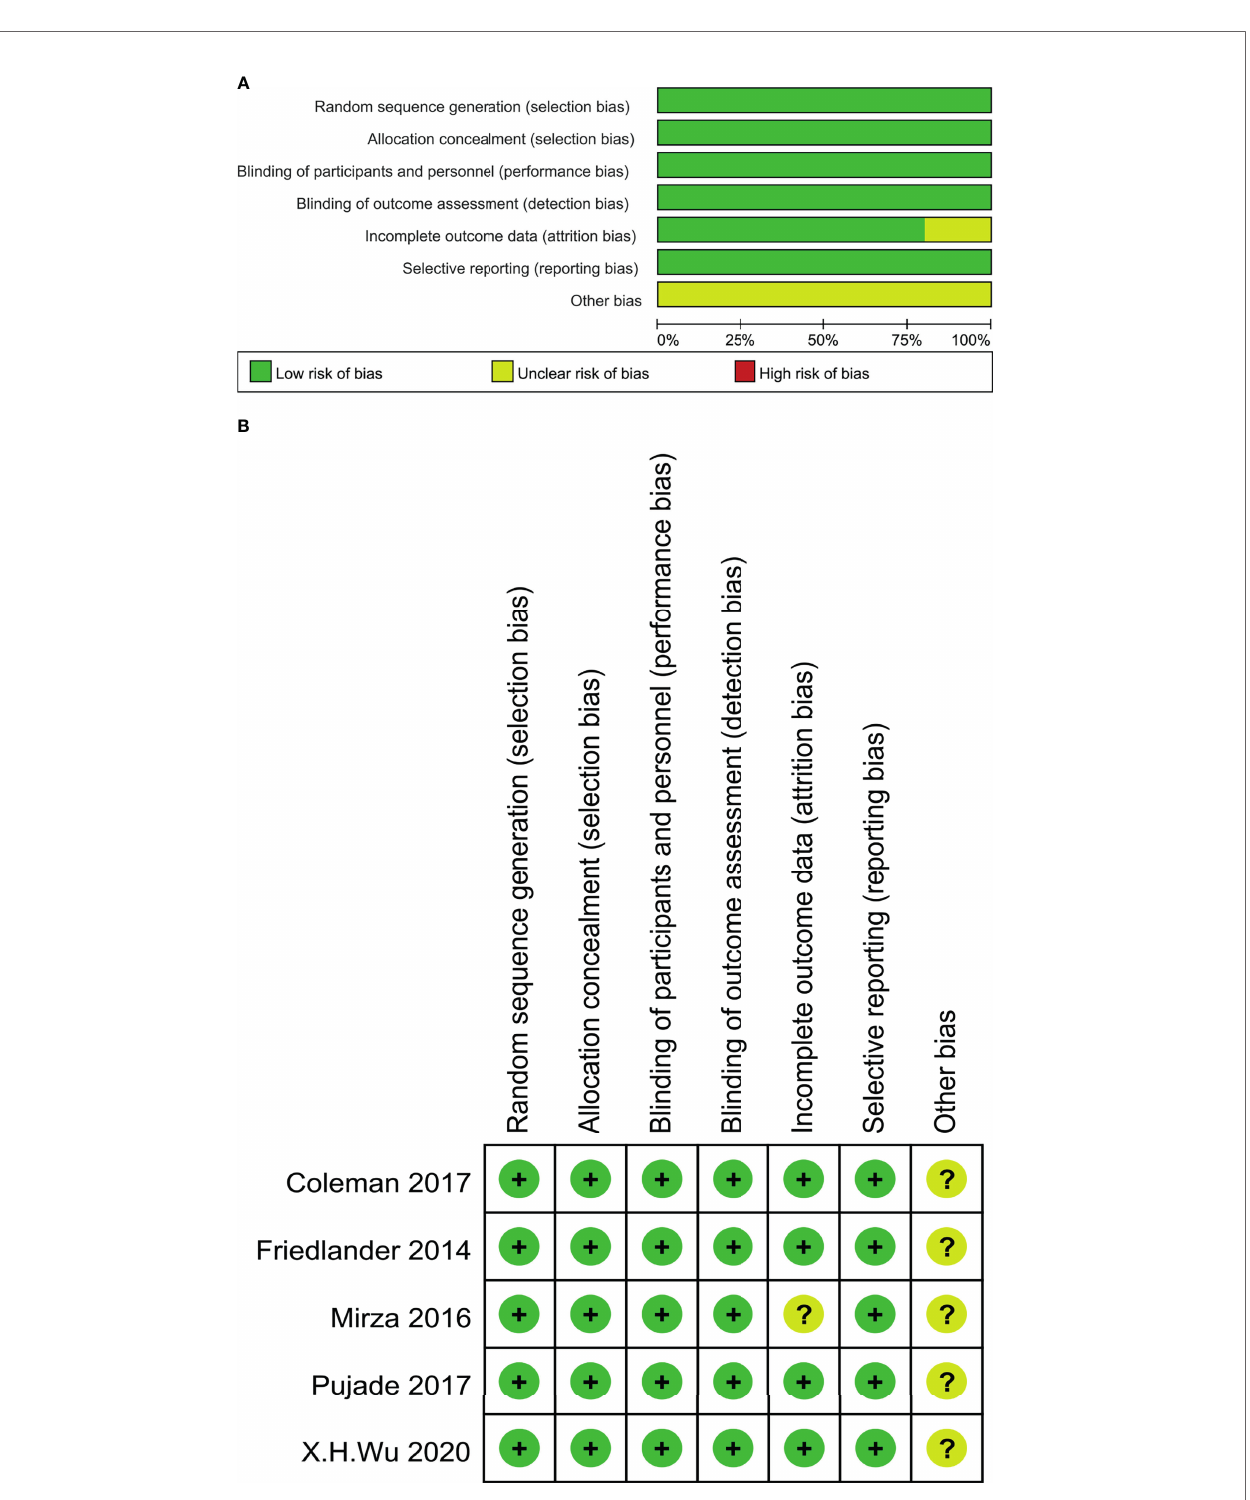
FIGURE 2 | (A) The risk of bias graph. The risk judgment for each bias item is presented as the percentage of all included studies. (B) The risk of bias summary. The risk judgment for each bias item is presented as the percentage of all included